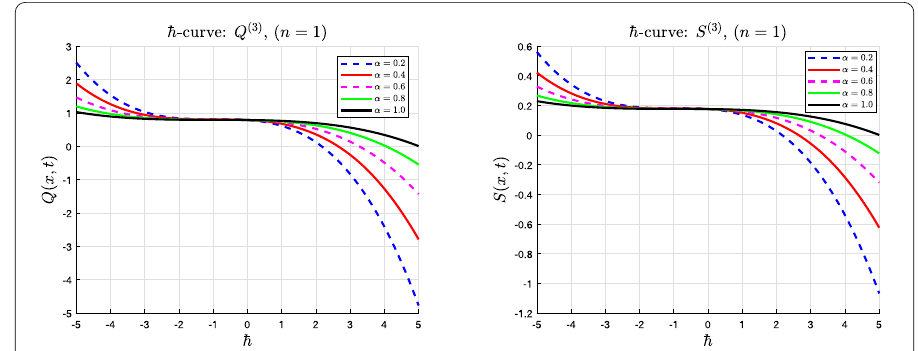
Figure 22 (cid:2) -curves plot with different α when r = 0.1, B = 3, x = 1, and t = 0.1 for Example 4.3